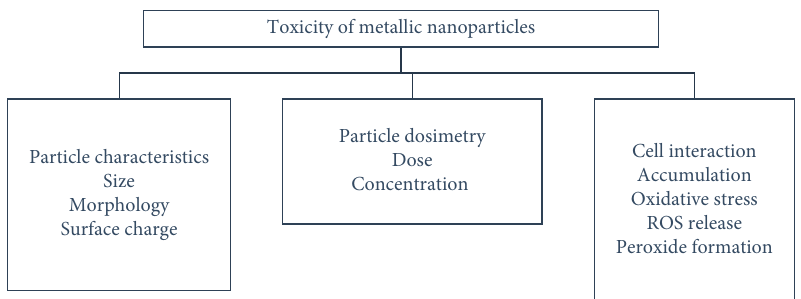
Figure 2: Characteristics and mechanisms of metal nanoparticles